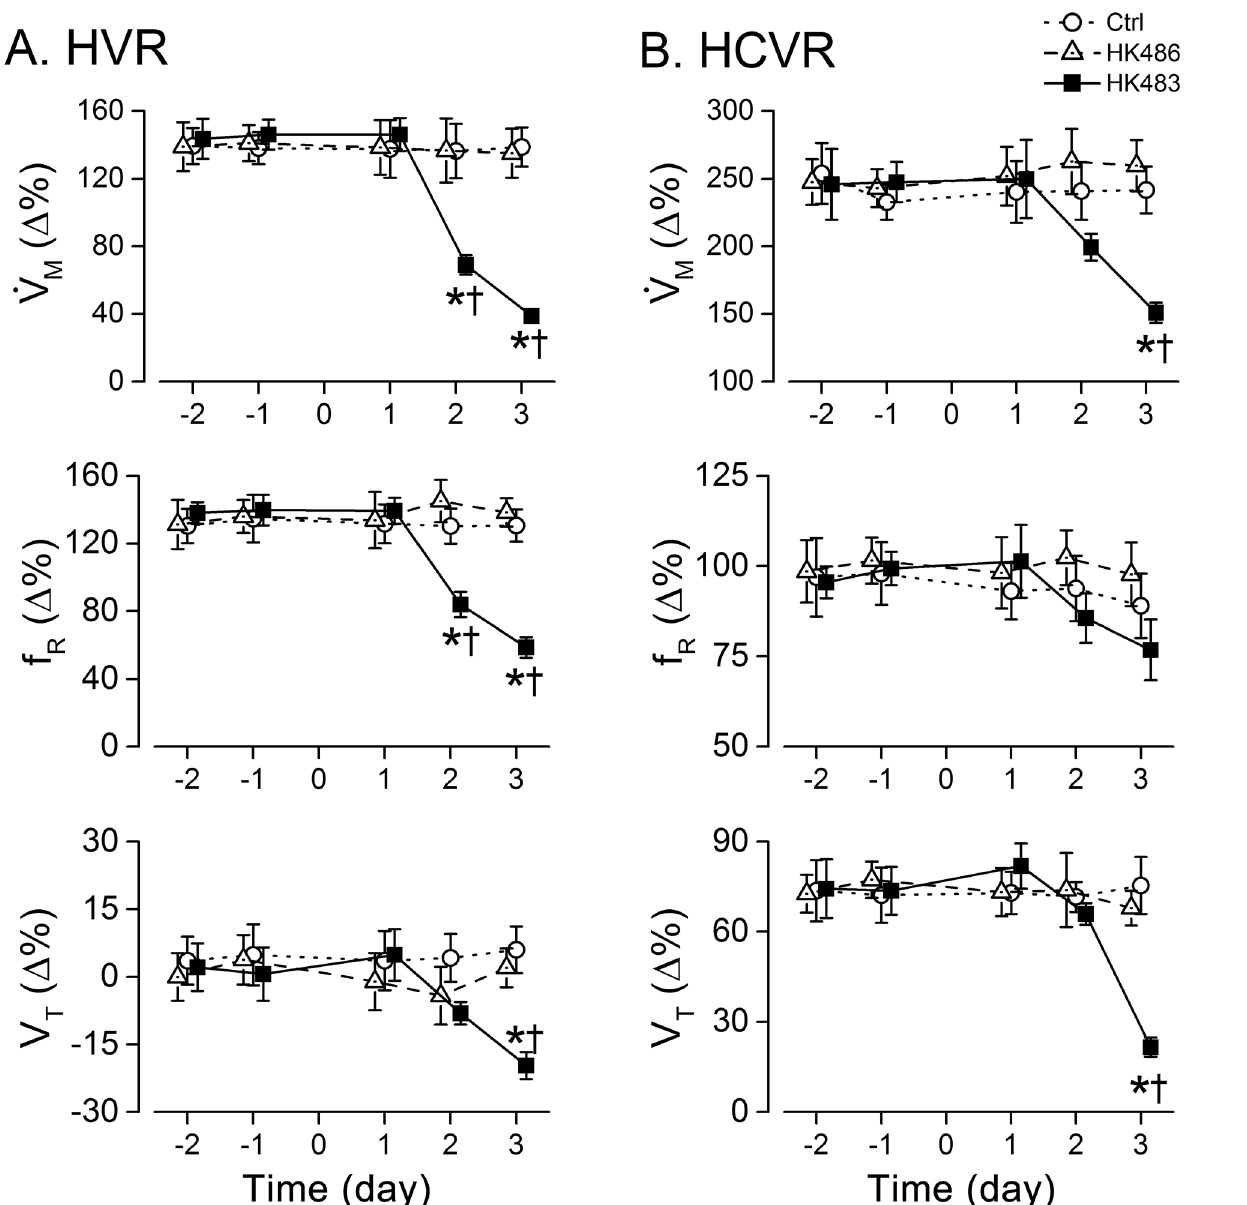
Fig 4. Comparison of viral infection effects on HVR (A) and HCVR (B) among Ctrl, HK483, and HK486 mice. HVR and HCVR were measured daily in individual mouse at 2 and 1 days before and 1, 2, and 3 days after intranasal inoculation (Day -2, -1, 1, 2, and 3). V frequency; and V T , tidal volume. Mean ± SE. n = 6, 15, and 7 for Ctrl, HK483 and HK486 mice. * P < 0.05 compared to the data obtained in previous day(s) and † P < 0.05 compared to Ctrl and HK486 mice at the same time-point. HK483 rather than HK486 viral infection produces HVR and HCVR depression at 2 and 3